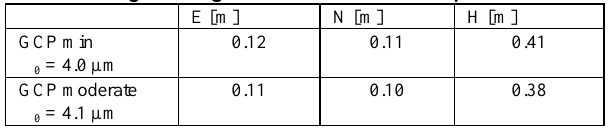
Table 4: Sigma naught and SDEV of terrain points